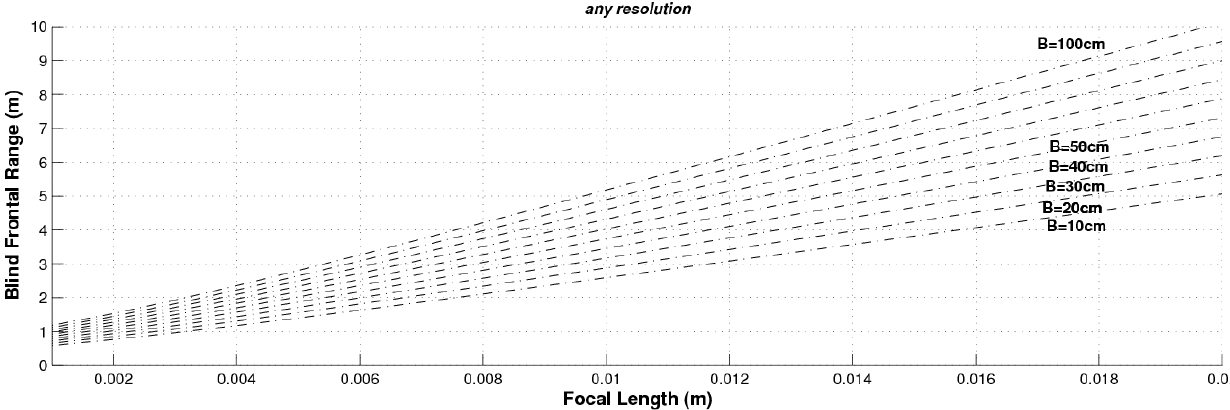
Figure 7. Blind frontal range as a function of the focal length, for different baselines. Note that the size of the images has no effect on the size of the blind frontal area.